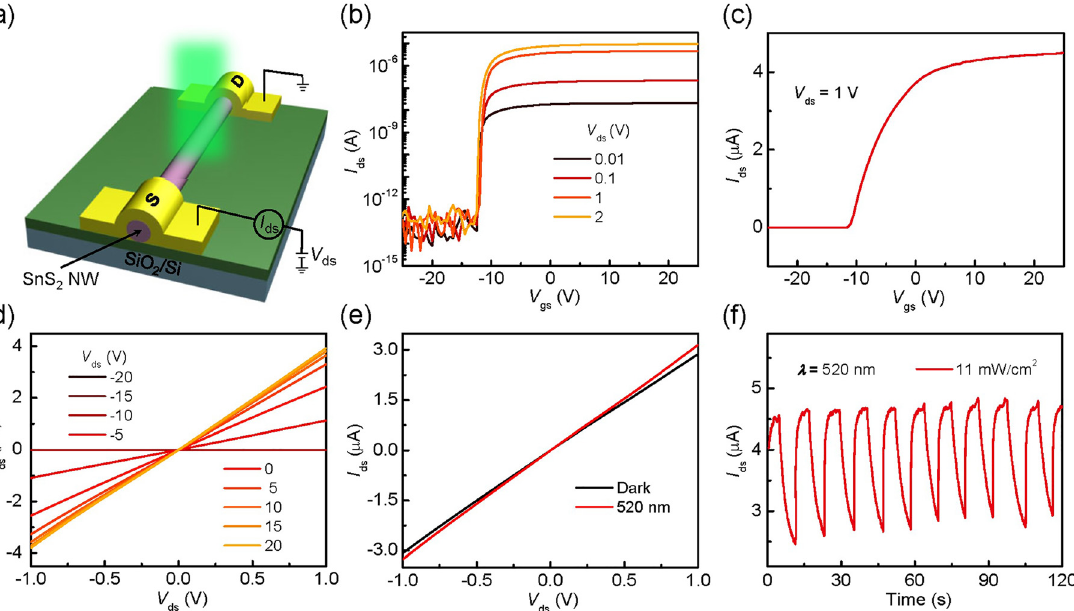
Figure 1: Characterizations of the as-grown SnS 2 NWs. (a) SEM image of SnS 2 NWs. The scale bar is 2 μ m. (b) HR-TEM image in- dicates a single-crystalline structure along the [001] growth direction of the single SnS 2 NW. The lattice distance is ∼ 0.296 nm and the scale bar is 2 nm. The bottom-left inset shows that the diameter of NW is about 40 nm (the scale bar is 50 nm). The top-right inset is the corresponding SAED pattern. (c) XRD pattern of the SnS 2 NWs (JCPDS No. 23-0677). (d) EDS spectrum of the SnS 2